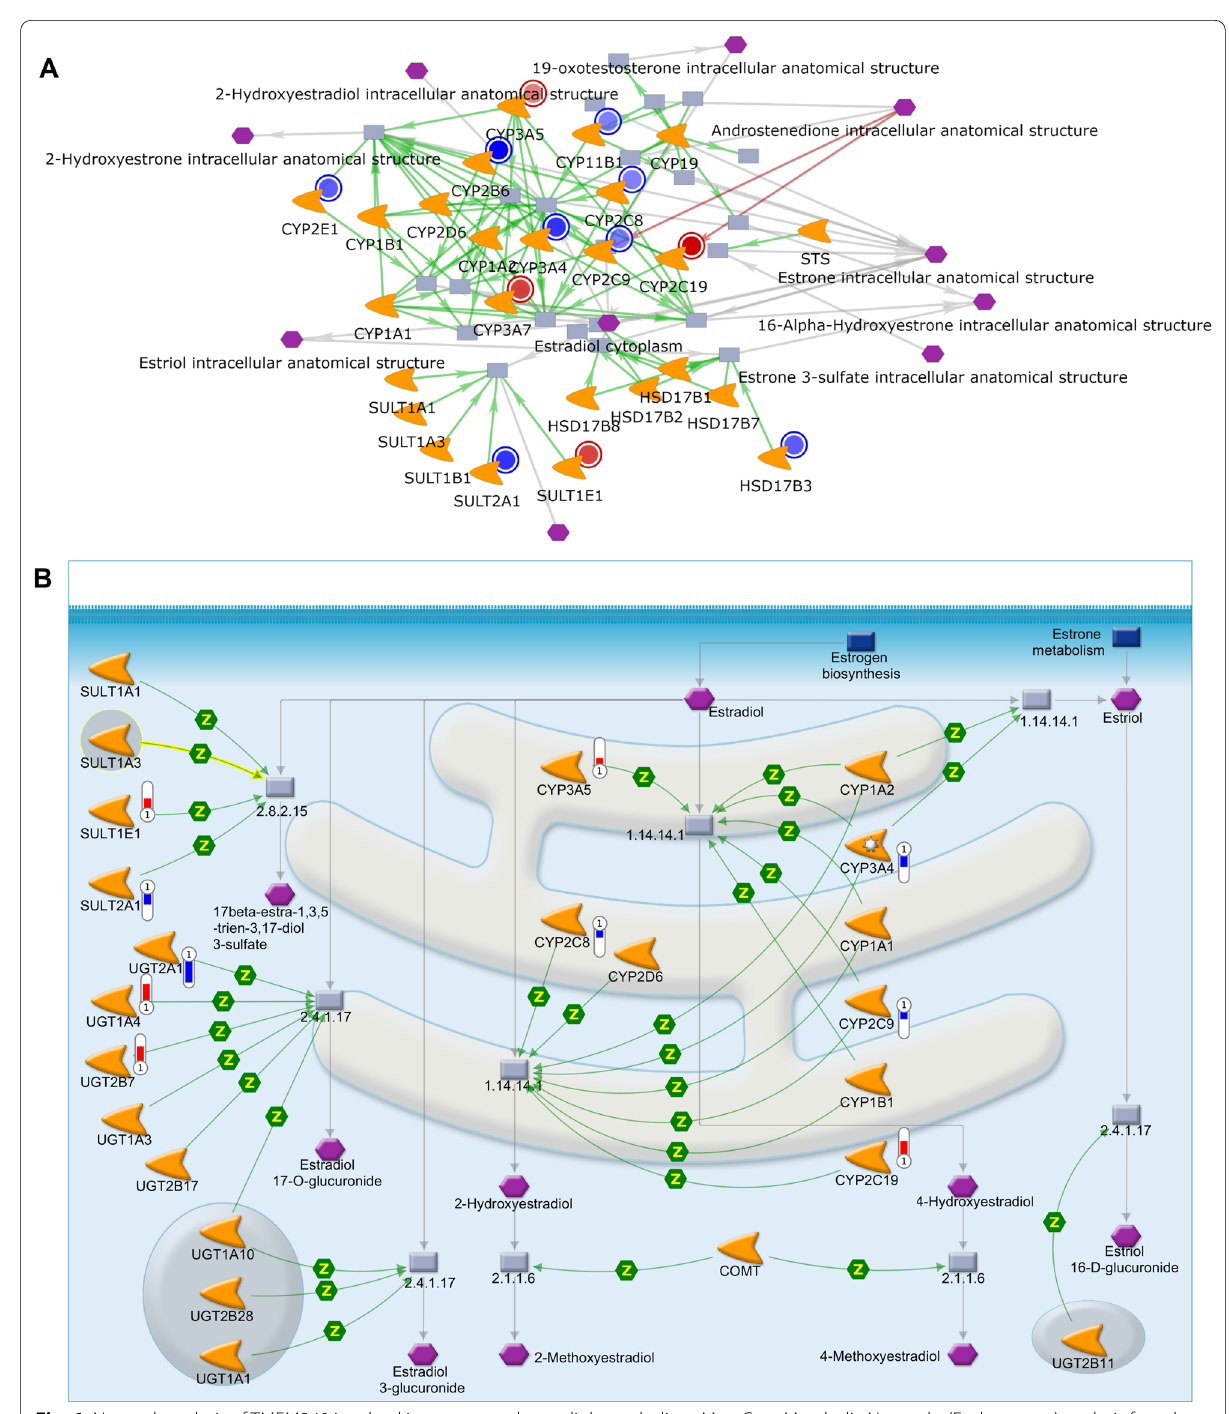
Fig. 6 Network analysis of TMEM240 involved in estrone and estradiol metabolism. MetaCore Metabolic Networks (Endogenous) analysis found that TMEM240 was involved in the metabolic networks of steroid, estrone, and estradiol metabolism ( A ). TMEM240, which is involved in estradiol metabolism, was identified with MetaCore Pathway Maps ( B ). RNA‑seq indicated decreases in CYP2B6, CYP11B1, CYP2C8, CYP2C9, CYP3A4, CYP2E1, HSD17B3, SULT2A1, SULT1B1, and UGT2A1 mRNA expression and increases in CYP2C19, CYP3A5, CYP3A7, SULT1E1, UGT1A4, and UGT2B7 mRNA expression under TMEM240 overexpression compared to the vector control. The enzymes are responsible for Androstenedione, Estrone, Estradiol, and Estriol metabolism